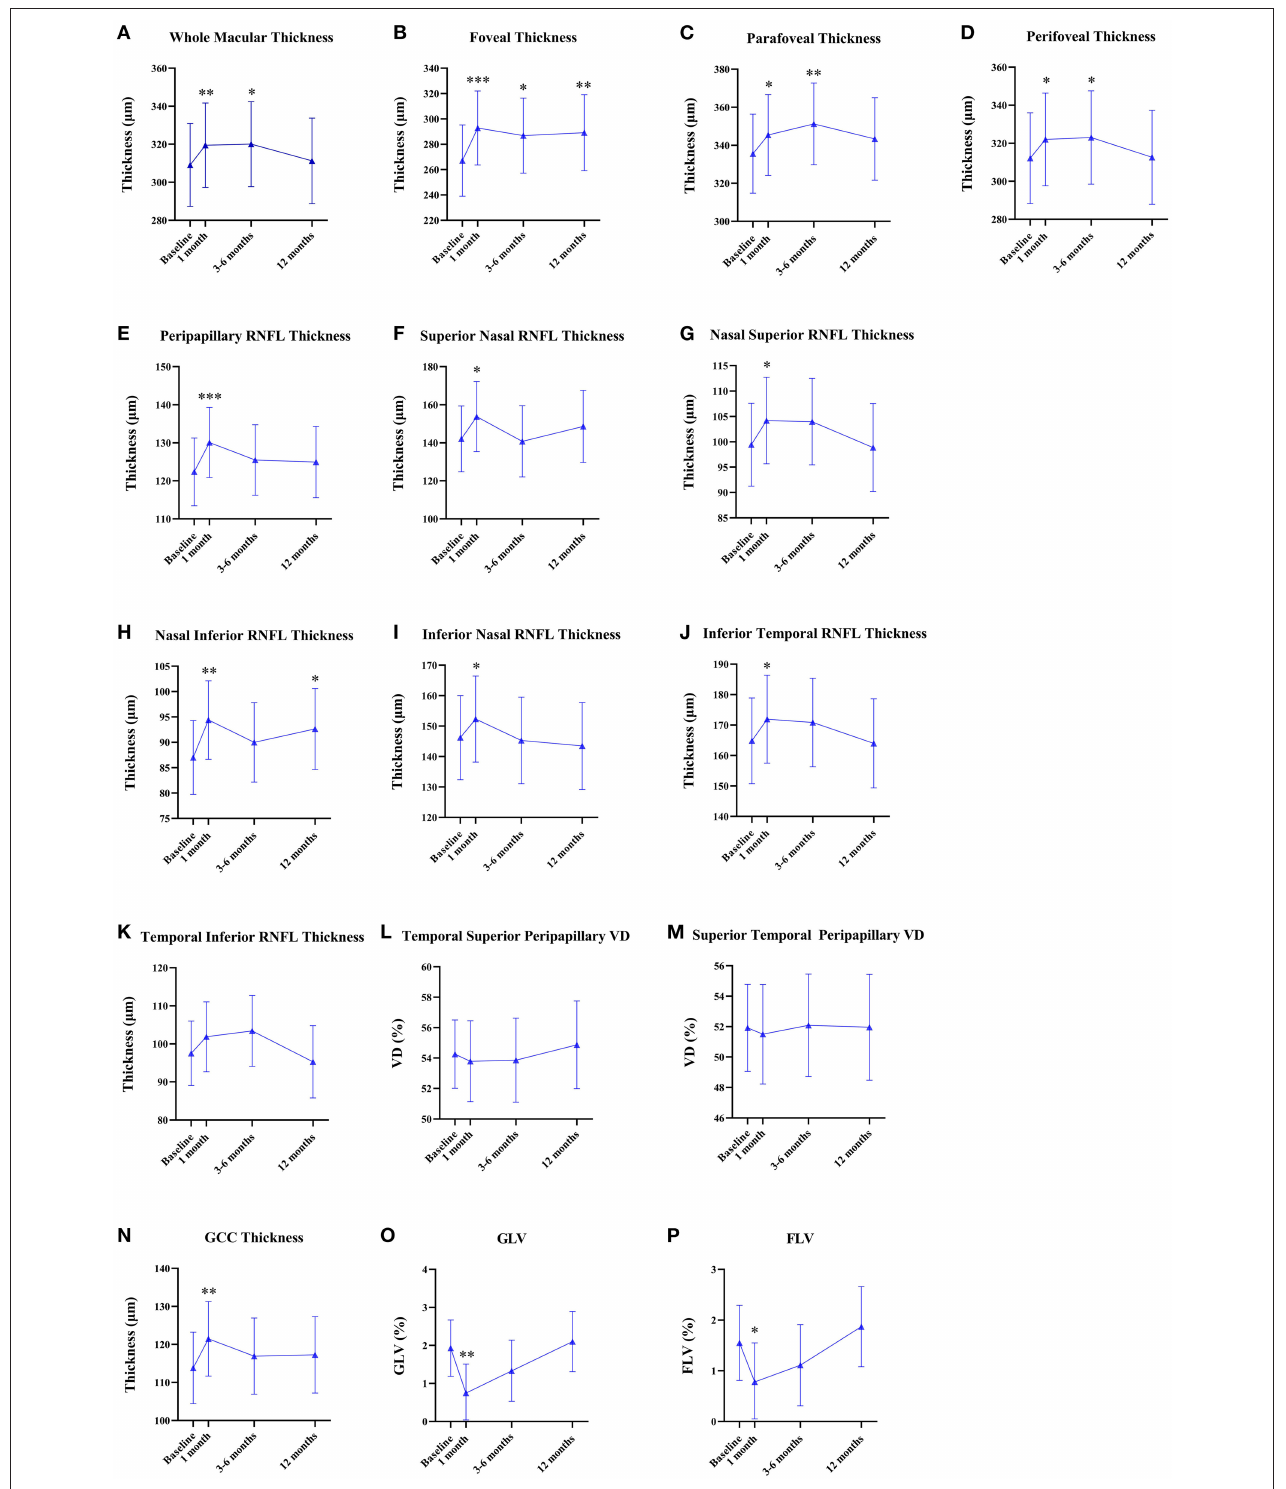
FIGURE 2 | Quantitative analyses of the longitudinal microvascular and neural changes in the macular and peripapillary areas during 12 months after panretinal photocoagulation (PRP). (A–D) Longitudinal changes of macular thickness [mean (95% CI), µ m] after PRP. (E–M) Longitudinal changes of peripapillary retinal nerve fiber layer (RNFL) thickness [mean (95% CI), µ m] after PRP. (N–P) Longitudinal changes of the ganglion cell complex (GCC) thickness [mean (95% CI), µ m]; global loss volume (GLV) [mean (95% CI), %]; and focal loss volume (FLV) [mean (95% CI), %] after PRP. * p < 0.05, ** p < 0.01, *** p < 0.001.